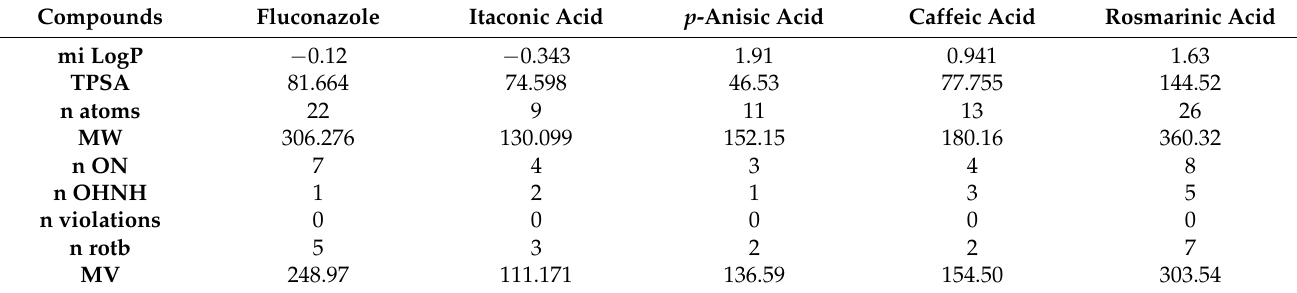
Table 2. Lipinski’s rule-of-five drug-likeliness properties of potential ICL inhibitors.